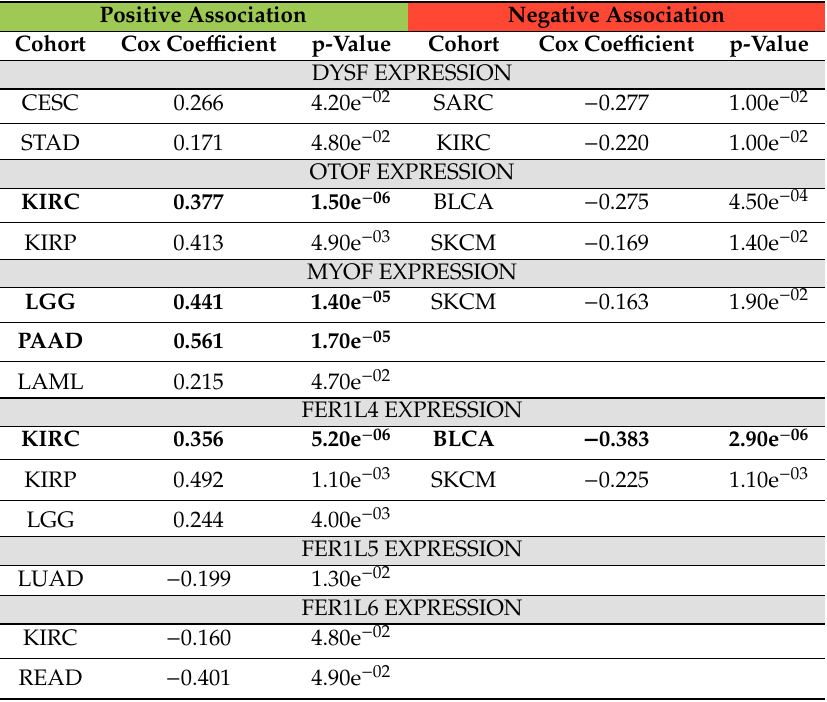
Table 3. Survival analysis by a Cox